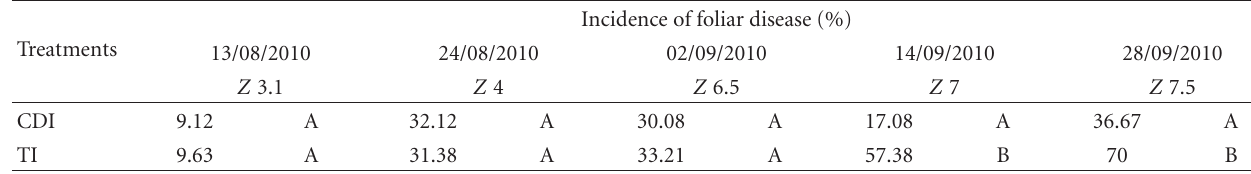
Table 10: Incidence (%) of foliar disease onset at di ff erent times of measurement for total irrigation (TI) and irrigation with controlled deficit (CDI) treatments.